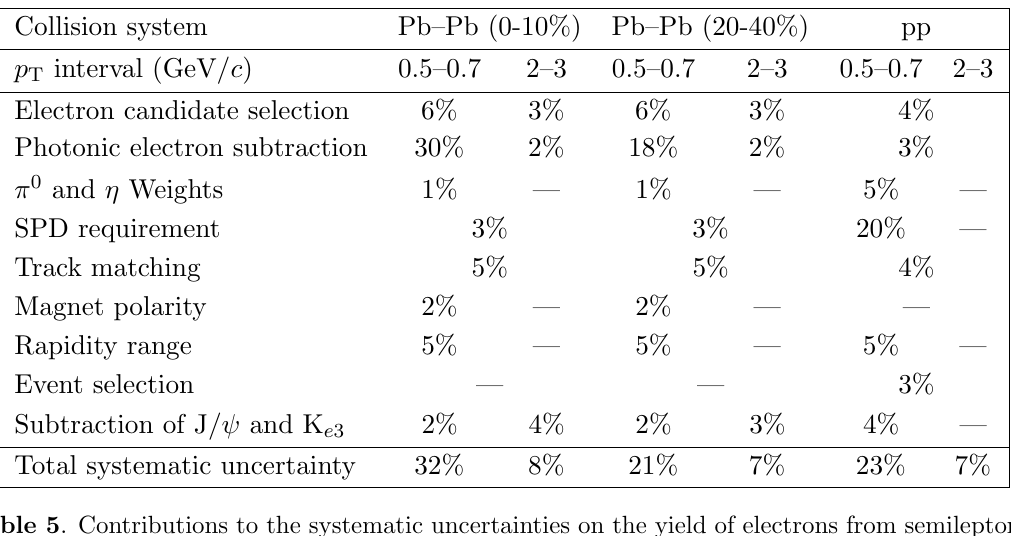
p -di(cid:11)erential invariant cross section for electrons from semileptonic heavy-(cid:13)avour T